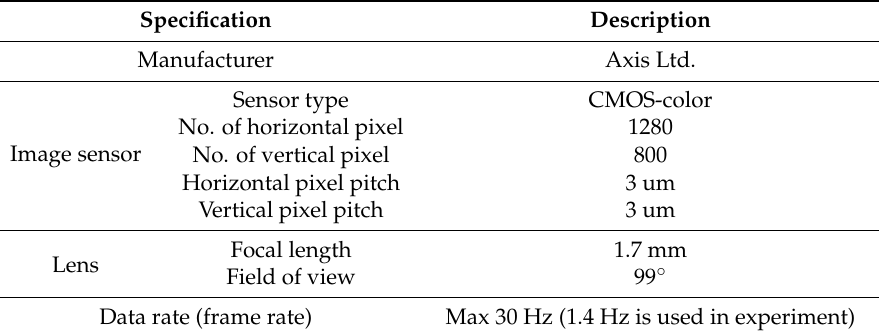
Table 5. Vision sensor specification for the experiment.